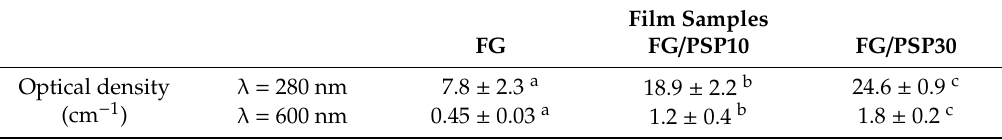
Table 3. Optical density ( n = 3) values of fish gelatin films with PSP (mean ± SD).